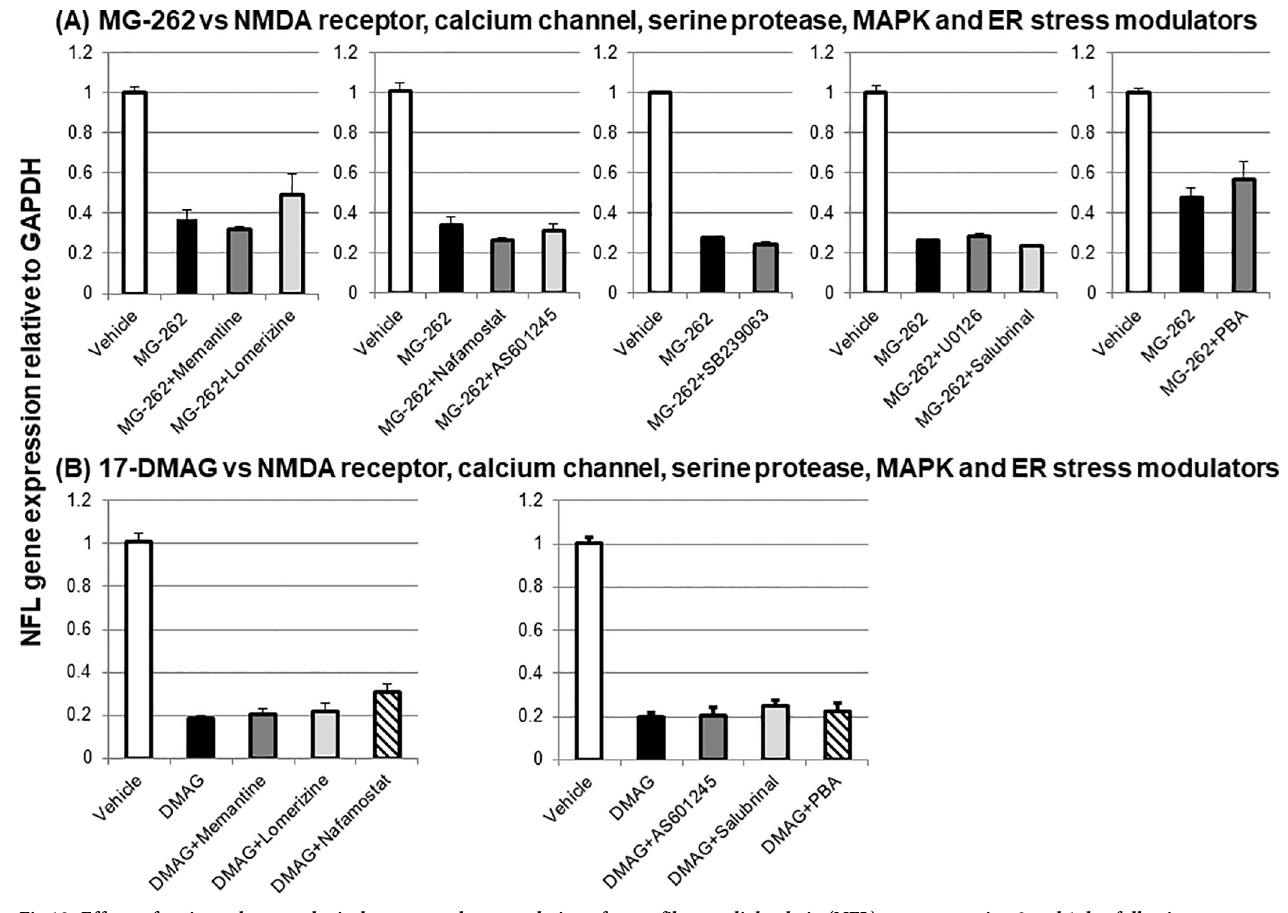
Fig 10. Effects of various pharmacological agents on downregulation of neurofilament light chain (NFL) gene expression 3 and 1 day following intravitreal injection of MG-262 and 17-DMAG, respectively. (A) Vehicle (open column, 10–100% DMSO in distilled water), MG-262 alone (closed column, 0.1 nmol/eye) and combined with the NMDA receptor antagonist memantine (dark grey, 100 nmol/eye), the calcium channel blocker lomerizine (light grey, 50 nmol/eye), the serine protease inhibitor nafamostat (dark grey, 10 nmol/eye), the JNK inhibitor AS601245 (light grey, 10.5 nmol/eye), the p38 inhibitor SB239063 (dark grey, 20 nmol/eye), the ERK inhibitor U0126 (dark grey, 50 nmol/eye), the ER stress modulator salubrinal (light grey, 50 nmol/eye) or sodium 4-phenyl butyrate (PBA, dark grey, 100 nmol/eye). (B) Vehicle (open column, 30–33% DMSO in distilled water), 17-DMAG alone (closed column, DMAG, 25 nmol/eye) and combined with memantine (dark grey, 100 nmol/eye), lomerizine (light grey, 50 nmol/eye), nafamostat (hatched, 10 nmol/eye), AS601245 (dark grey, 10.5 nmol/eye), salubrinal (light grey, 12.5 nmol/eye) or PBA (hatched, 100 nmol/eye). Each pharmacological agent was premixed with a proteasome inhibitor and concurrently administered to animals. Following intravitreal injection, the retina was isolated and NFL gene expression was determined by real time PCR. The NFL gene expression level was normalized to that of GAPDH in each retinal sample and shown as the value relative to the respective control. Each value represents the mean ± S.E.M. of 5 to 10 eyes from 3 to 5 animals. Note that NFL downregulation by MG-262 and DMAG alone was statistically significant compared with the respective control group by Tukey’s multiple comparison